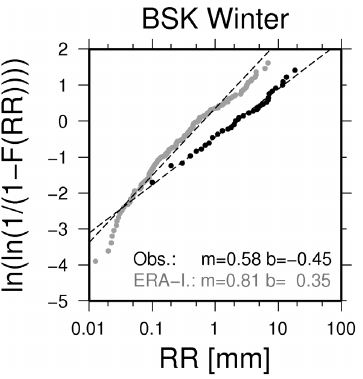
Fig. 3. Estimation of Weibull parameters by linear regression at the station Bou Skour. Black dots: Observed values; grey dots: ERA- Interim Reanalysis data interpolated to test site location.